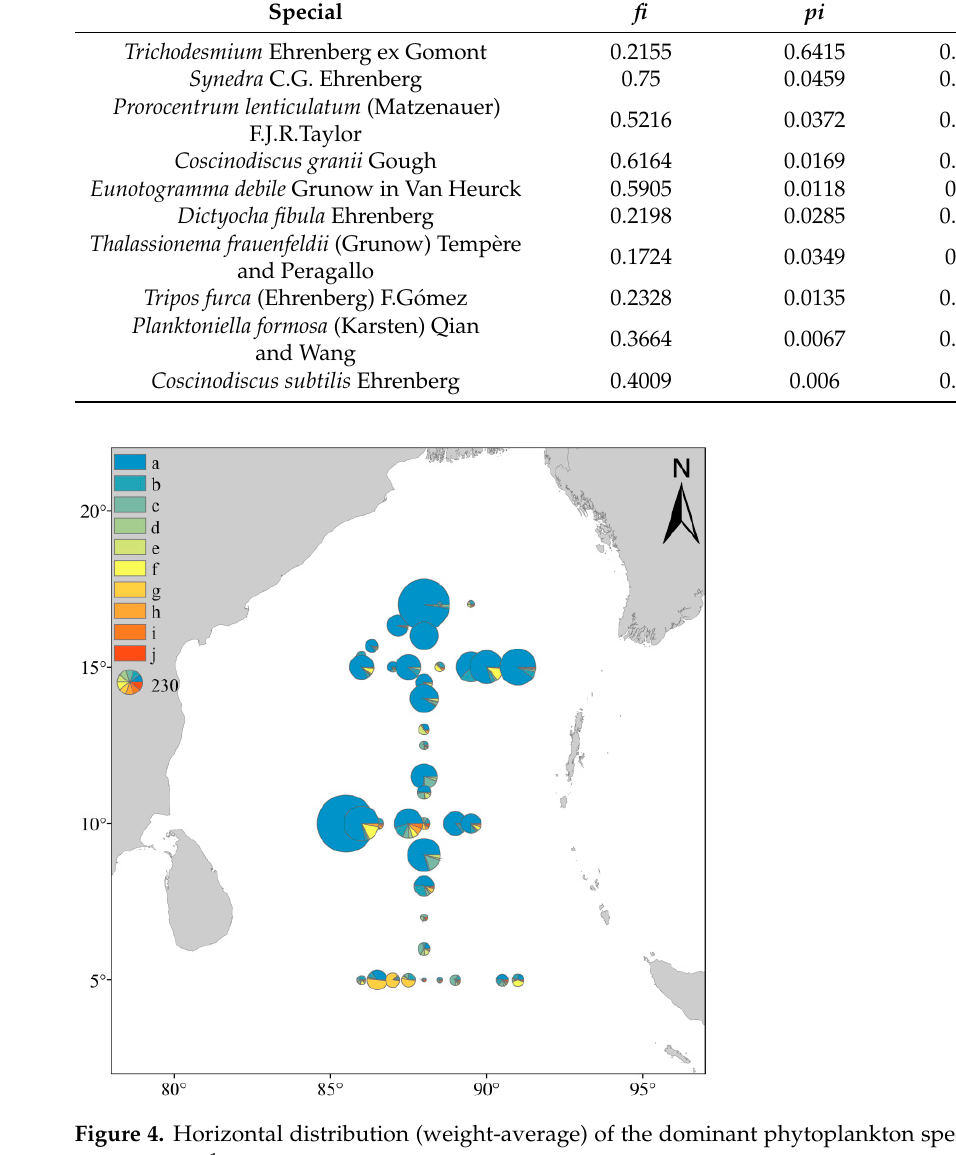
Figure 4. Horizontal distribution (weight-average) of the dominant phytoplankton species in the BOB (cells L − 1 ). (a) Trichodesmium spp.; (b) Synedra spp.; (c) Prorocentrum lenticulatum; ( d) Coscinodis- cus granii; ( e) Eunotogramma debile; ( f) Dictyocha fibula; (g) Thalassionema frauenfeldii; (h) Tripos furca; (i) Planktoniella formosa; (j) Coscinodiscus subtilis.